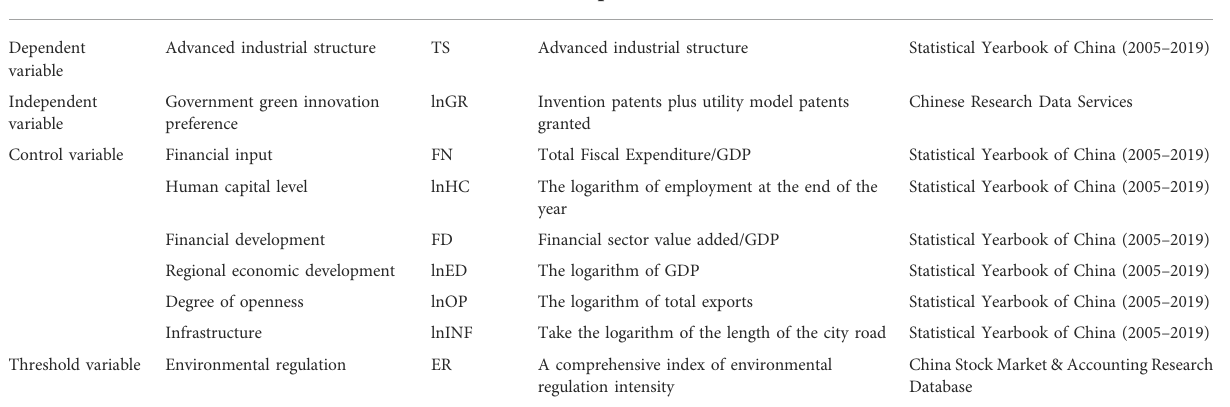
TABLE 1 Summary of the